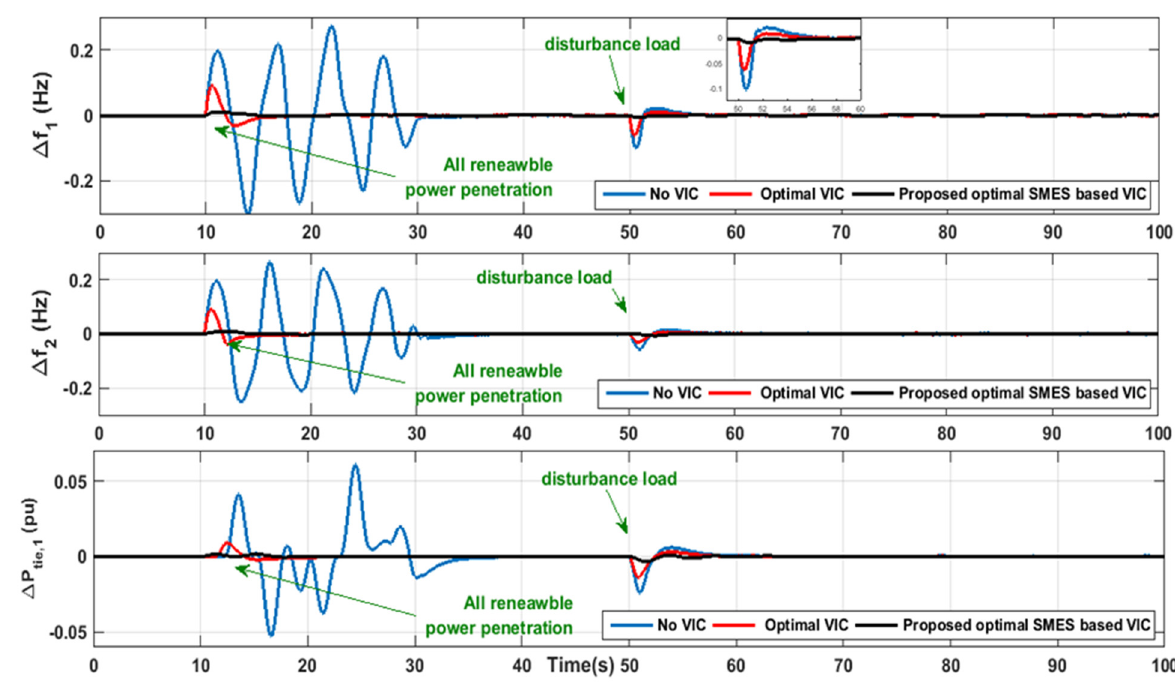
Figure 17. The system under consideration performance for case A, scenario 3.